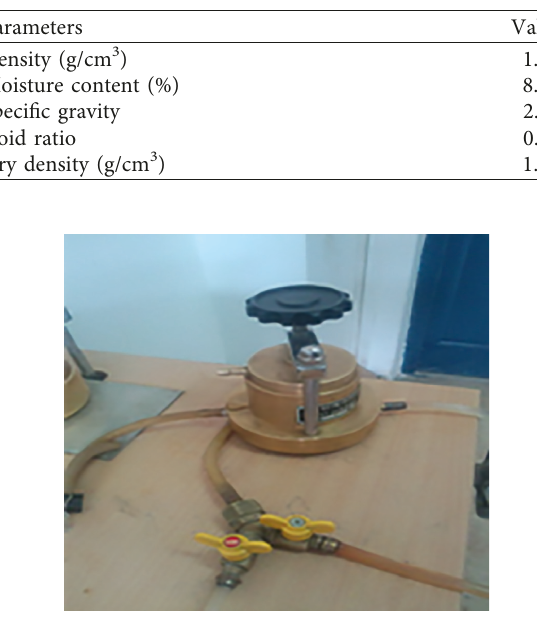
Figure 5: The instrument of the variable water head permeability test.